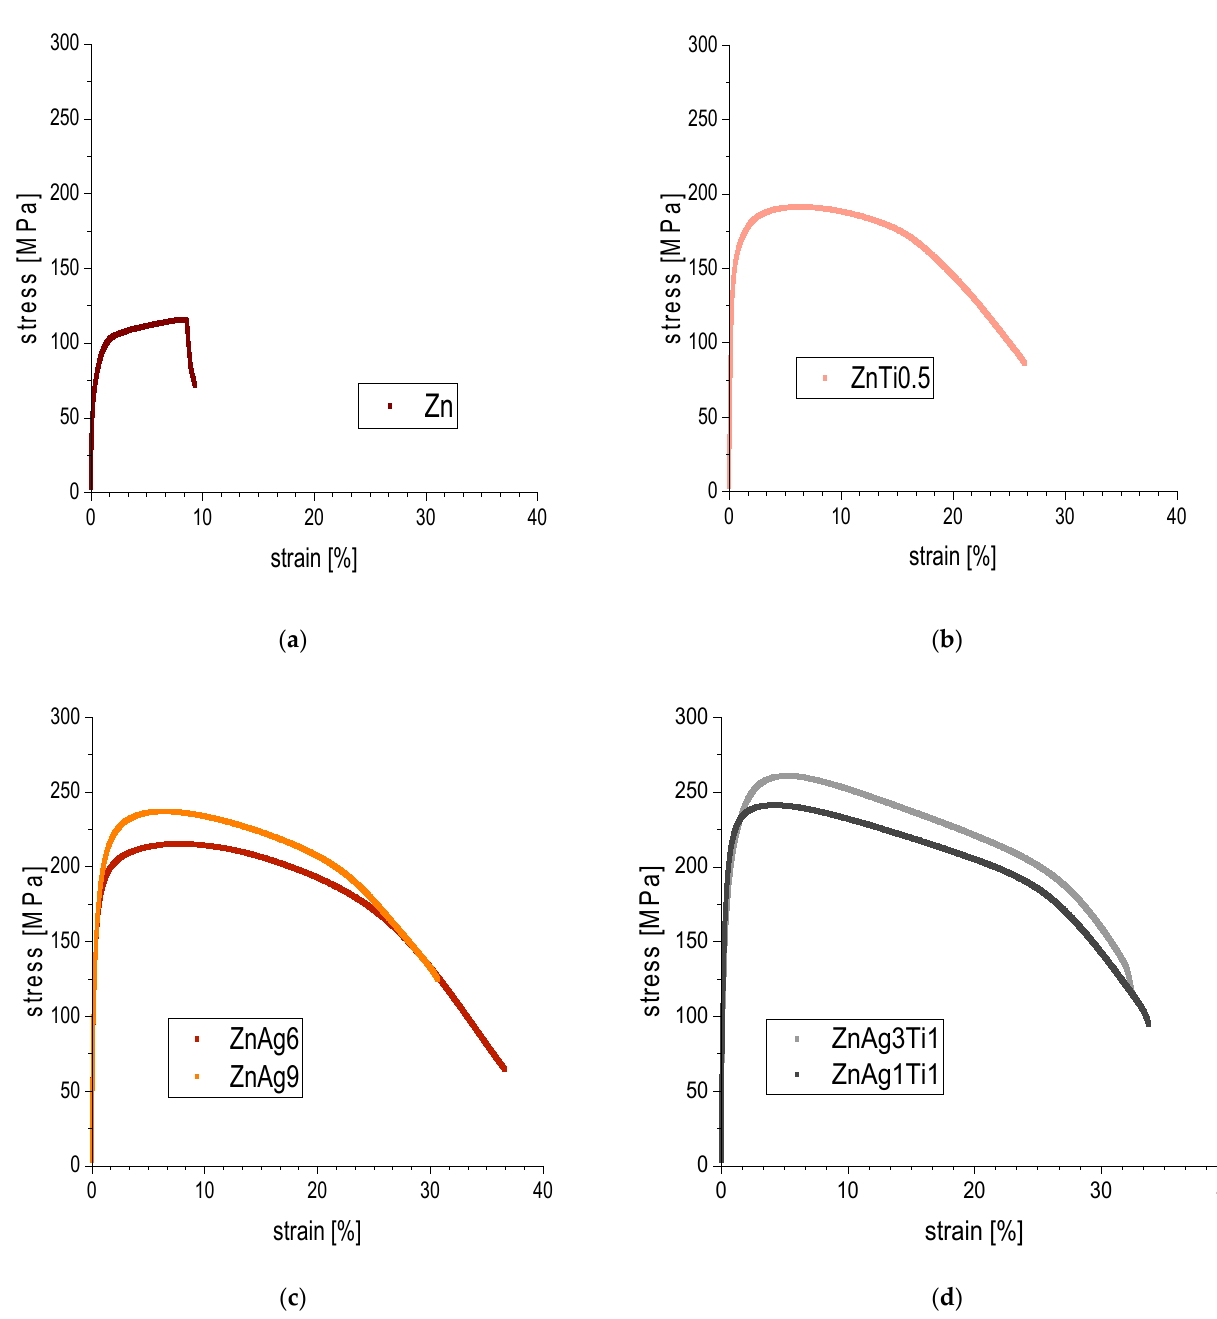
Figure 4. Averaged stress–strain curves of all tensile tests with the ZwickRoell Z005 materials testing machine and recorded with TestXpert3, with ( a ) pure zinc, ( b ) ZnTi0.5 alloy, ( c ) zinc silver alloys, and ( d ) zinc silver titanium alloys.